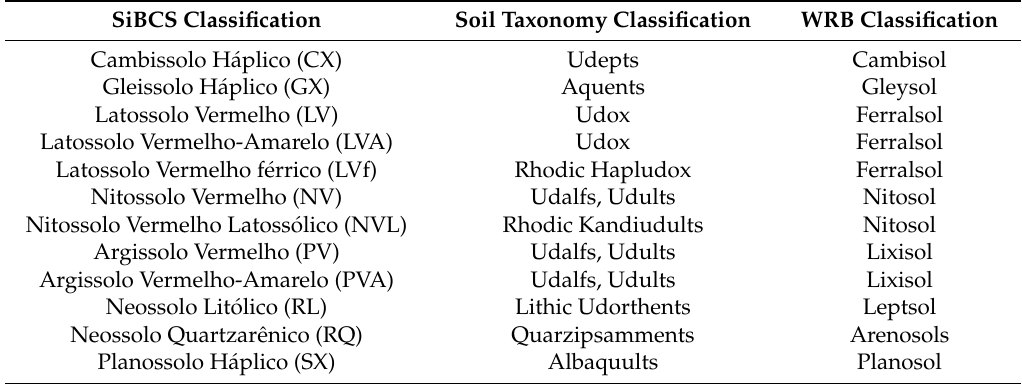
Table 1. Soil suborders according to the Brazilian Classification System [28], and corresponding Soil Taxonomy [31], and Word Reference Base